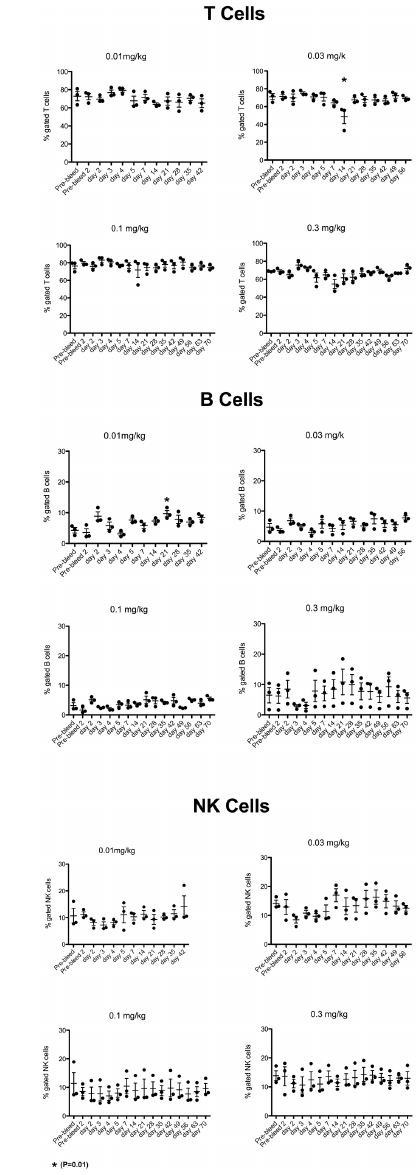
Figure 4. Cynomolgus macaques (n=3 per dose group) were dosed with a single dose of 0.01 mg/kg, 0.03 mg/kg, 0.1 mg/kg and 0.3 mg/kg of NKTT120, respectively and subsequently bled at indicated time points. Whole blood samples were stained with antibodies against CD3 (SP34.2), CD20 (2H7), TCR Vα24 (C15), CD159a (Z199) and invariant TCR (6B11). Subsequently red blood cells lysed, cells washed and analyzed by flow cytometry. T cells were identified as CD20-, CD3+ and 6B11- lymphocytes, B cells were identified as CD3-, CD20+ lymphocytes and NK cells were identified as CD3-CD159a+ lymphocytes. T, B and NK cells are reported as % of lymphocytes One way ANOVA with multiple comparison followed by a non-parametric T test was performed using PRISM software on all the subsets. * indicates significant difference to pre-bleed values (P=0.01).